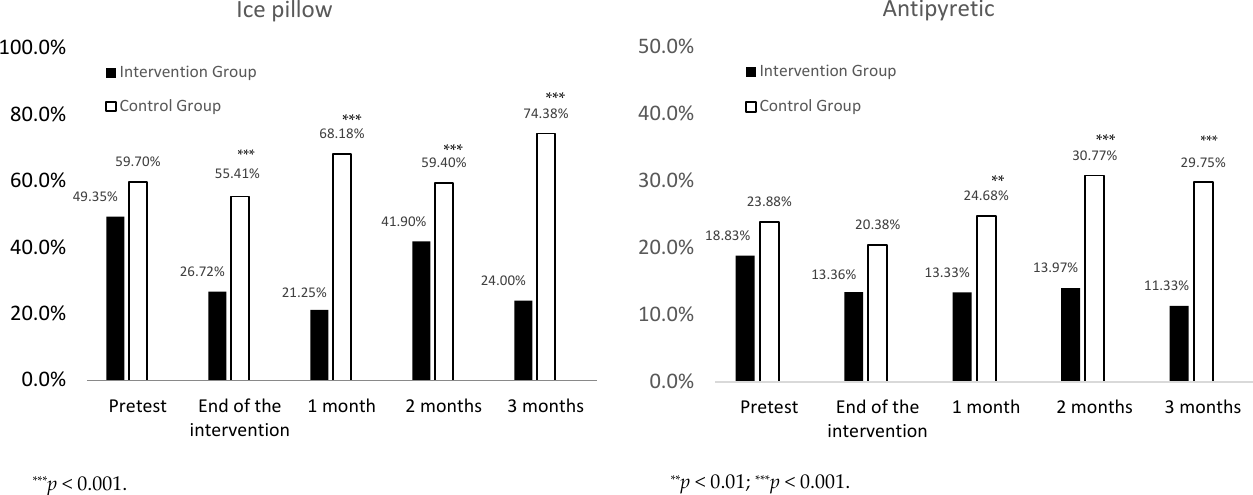
Figure 1. Percentage of ice pillows and antipyretics usage at different time points.